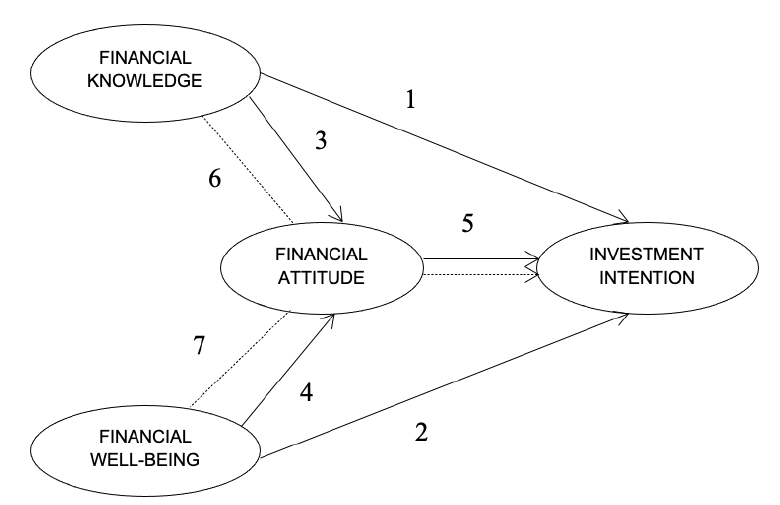
Figure 1: Research Conceptual